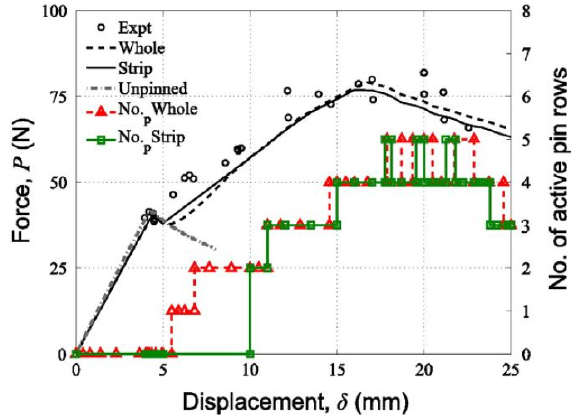
F igure 58. Initiation and development of the bridging effect in a z-Pinned laminate (numerical and